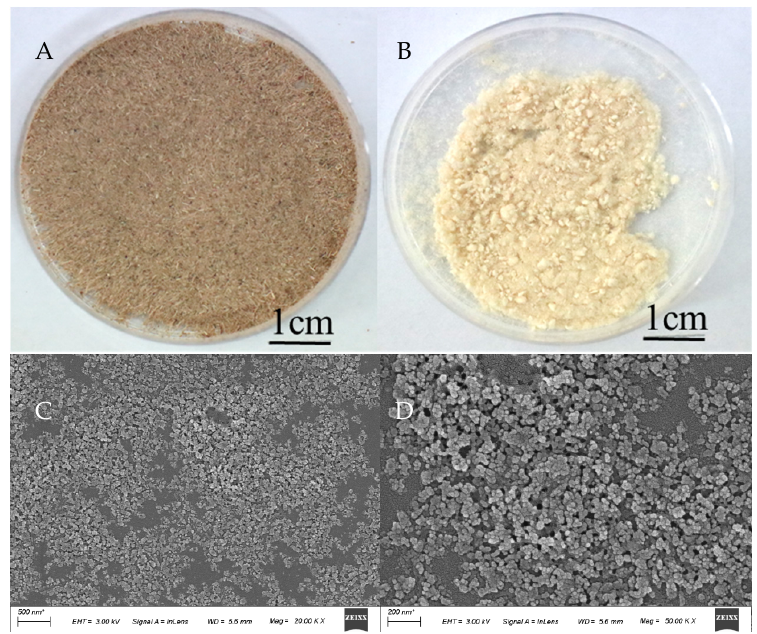
Figure 9. Morphological observation of the raw biomass ( A ), crude cellulose ( B ), and the CNC ( C , D ) of Miscanthus × giganteus .